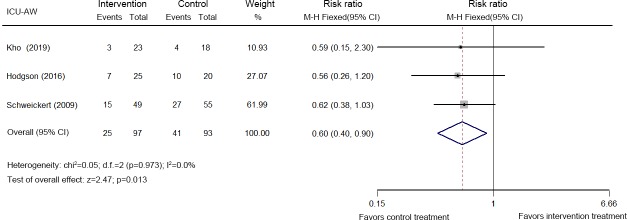
Forest plot of the eligible studies that reported ICU-AW at hospital discharge.